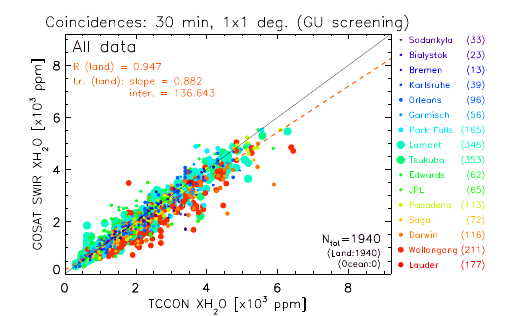
Figure 4. Correction of Figure 4 in [1]. Scatter plot of the GOSAT TANSO-FTS XH 2 O and coincident TCCON soundings (criteria of ± 30 min and ± 1 ◦ in latitude/longitude). For these criteria, there are no coincident TANSO-FTS ocean scans. The caption and color-coding are identical to those of Figure 3.